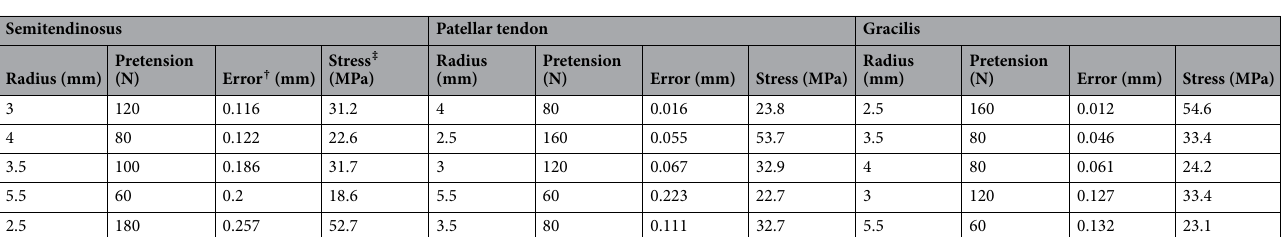
Table 2. Qualitative results depicting the five best models and parameter combinations for each of the three grafts. The best performing model (gracilis minimum error) exhibits very high-stress values. A 4 mm radii and 80 N pretension rank well in terms of less stress and satisfying displacement error. difference in relative knee displacement between the ACLR FE model and RM.